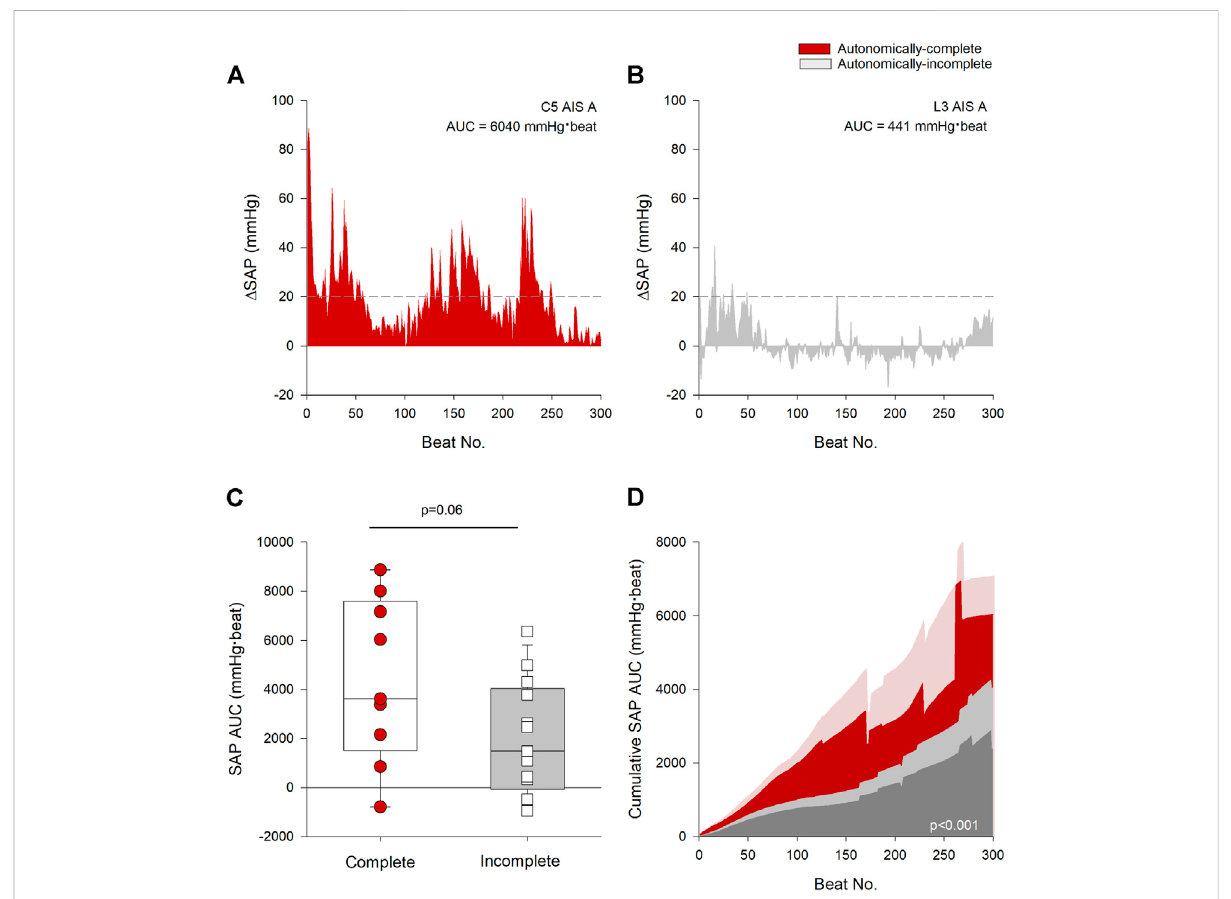
FIGURE 3 Autonomic injury was associated with greater severity and burden of AD. (A) Change in beat-to-beat systolic arterial pressure (SAP) recorded fromanindividualwithaC5AISAautonomically-completeinjuryduringthe fi rst300beatsofurodynamicstesting(UDS). (B) Changeinbeat-to-beat SAP recorded from an individual with an L3 AIS A autonomically-incomplete injury during the fi rst 300 beats of UDS. Threshold criteria for the diagnosis of AD is outlined in (A,B) using a dashed line at +20 mmHg. (C) Individuals with autonomically-complete injuries tended to have increased SAP AUC compared to those with autonomically-incomplete injuries ( p = 0.06). (D) Mean cumulative area under the curve (AUC) for systolic pressure over the fi rst 300 beats during UDS by completeness of injury. Red area denotes autonomically-complete injuries and grey area denotes autonomically-incomplete injuries. Respective pale shaded areas denote corresponding standard error. Note that the AUC is signi fi cantly larger in those with autonomically-complete injuries compared to those with autonomically-incomplete injuries ( p < 0.001). Statistical signi fi cance: straight line ( – ) denotes statistical difference between groups. Abbreviations: AD, autonomic dysre fl exia; SAP, systolic arterial pressure; AUC, area under the curve; UDS, urodynamics